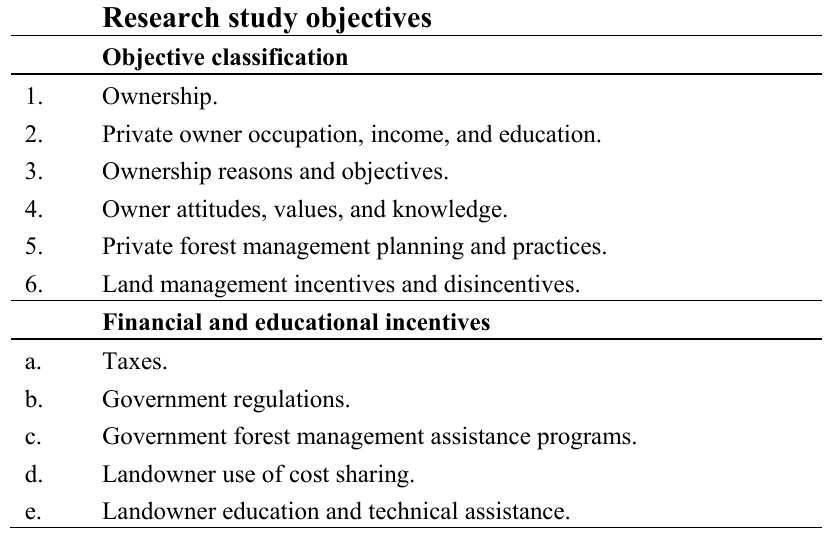
Table 2. Current motivation-based approach to NIPF owner research studies